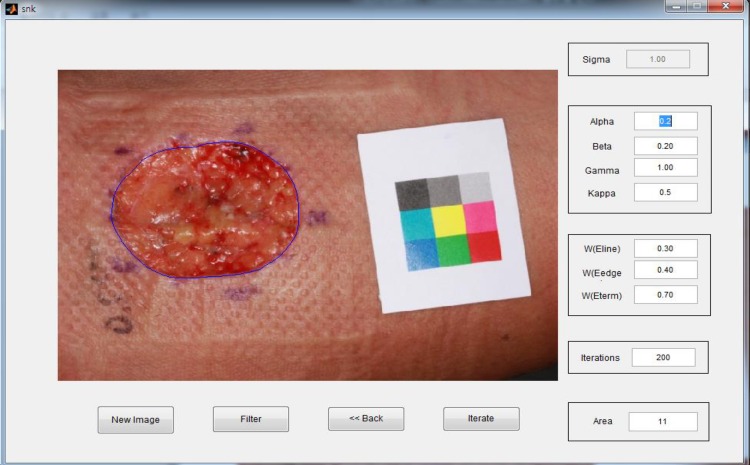
Wound image analysis using a color patch method.The area which shows different color and texture compared to around normal skin area was automatically defined as a skin wound using the devised software tool.